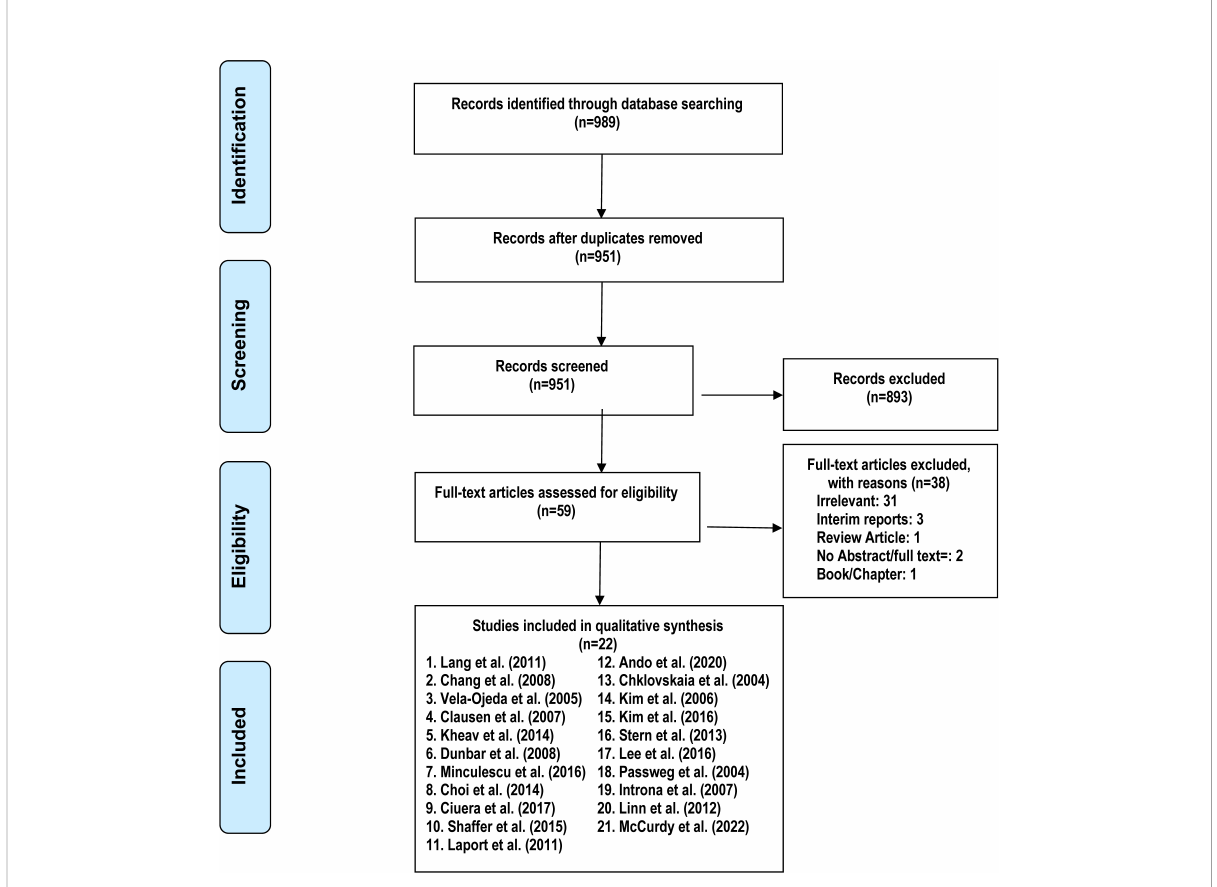
FIGURE 1 PRISMA diagram of included and excluded